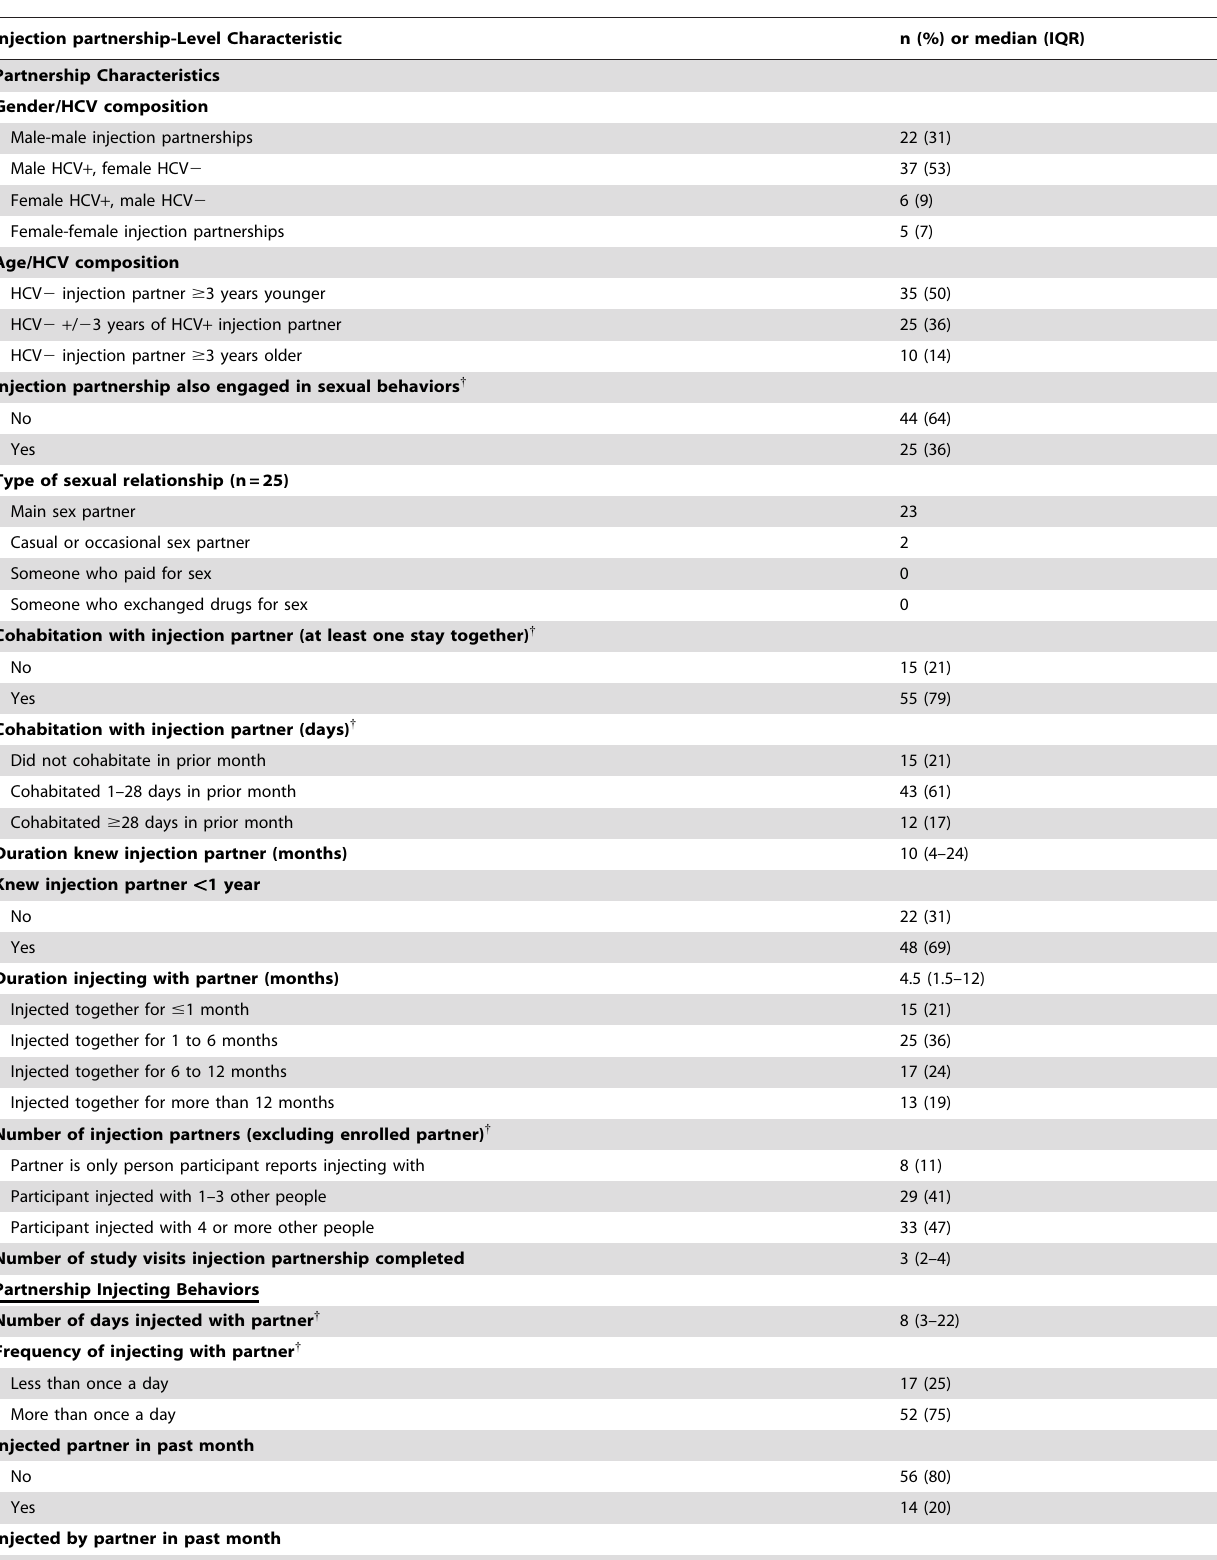
Table 2. Injection partnership-level characteristics and behaviors at enrollment, reported by the at-risk HCV-negative partner